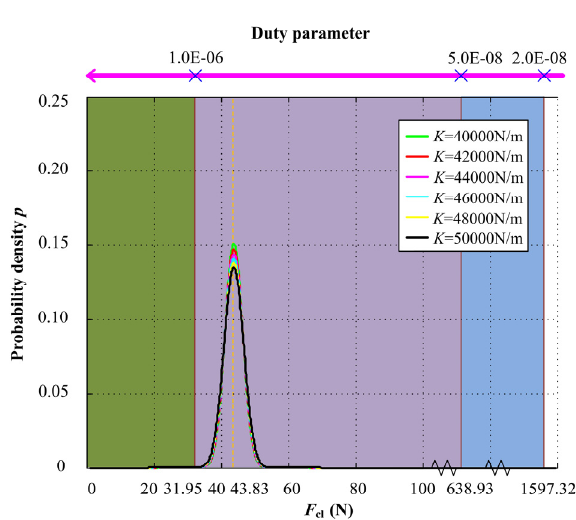
Figure 12. Probability density of closing force F cl under different axial stiffness and the relationship with duty parameter G.